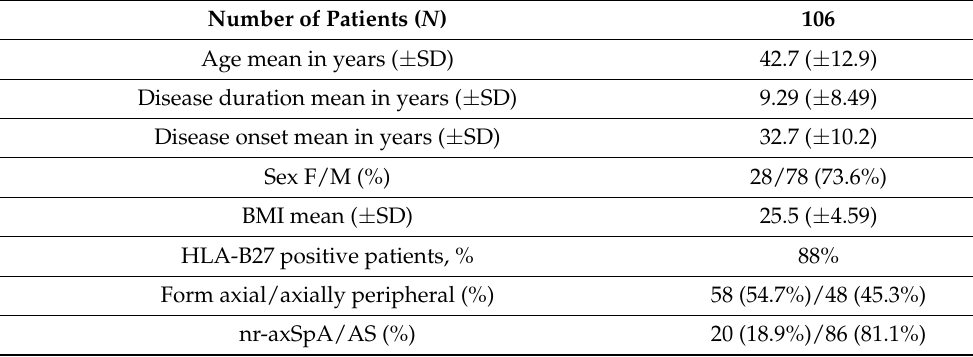
Table 1. Clinical characteristics of the patients’